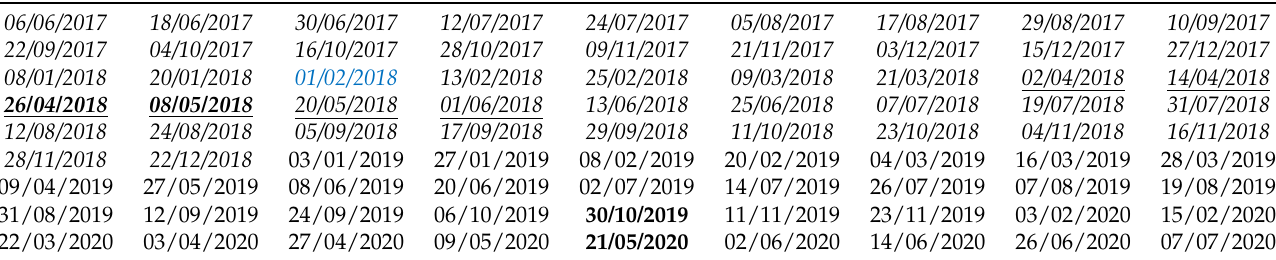
Table 1. Acquisition days of the Sentinel-1 data. Italic font: images used for calibration; bold font: images used to produce flood maps in rural/suburban areas; underlined font: images excluded from the persistent scatterers (PSs) identification; blue text: master image for the PSs